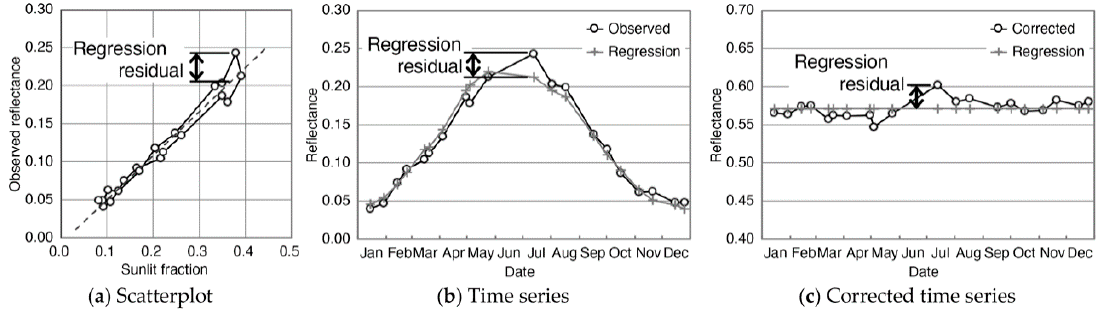
Figure 4. Outline of the pixel-based correction: ( a ) scatterplot of the sunlit fraction and observed reflectance of one pixel of the Sentinel-2/MSI time series, with linear regression and regression residuals; ( b ) seasonal time series of the observed reflectance and estimated reflectance by the regression; and ( c ) corrected reflectance at 1.0 sunlit fraction.